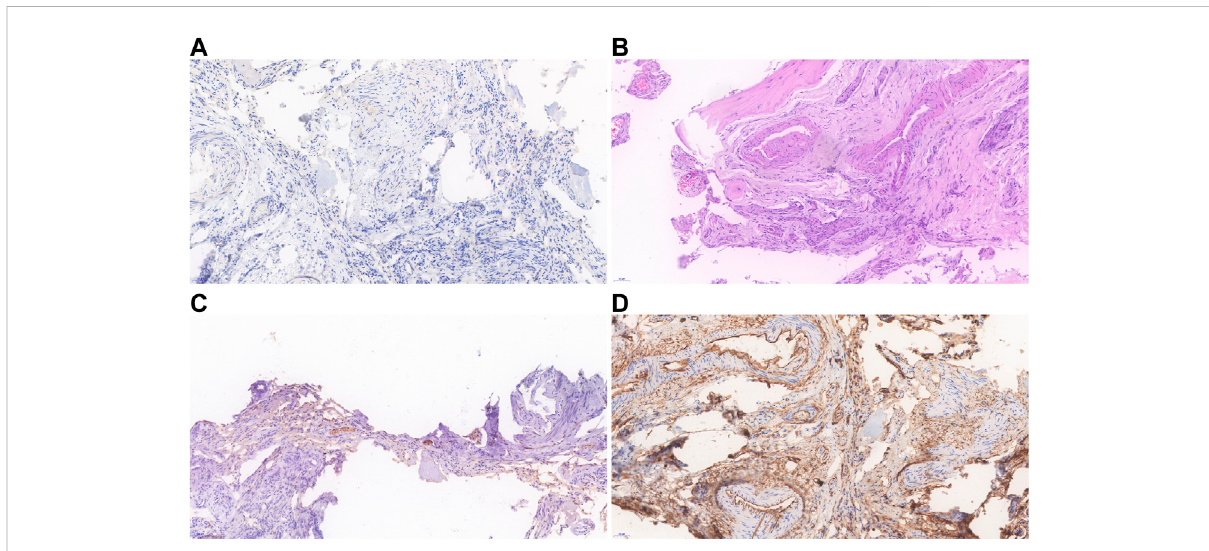
FIGURE 4 Histopathological fi ndings of the proband ’ s neuro fi broma. (A) Immunohistochemistry showed that the lymphatic marker D2-40 was negative. (B) Spindle tumor cells aredistributedinbundles with bone destruction,and thetumor is richinblood vessels. (C) Expression ofS-100 wasscattered in tumor. (D) CD34 expression was positive in vascular endothelial cells.